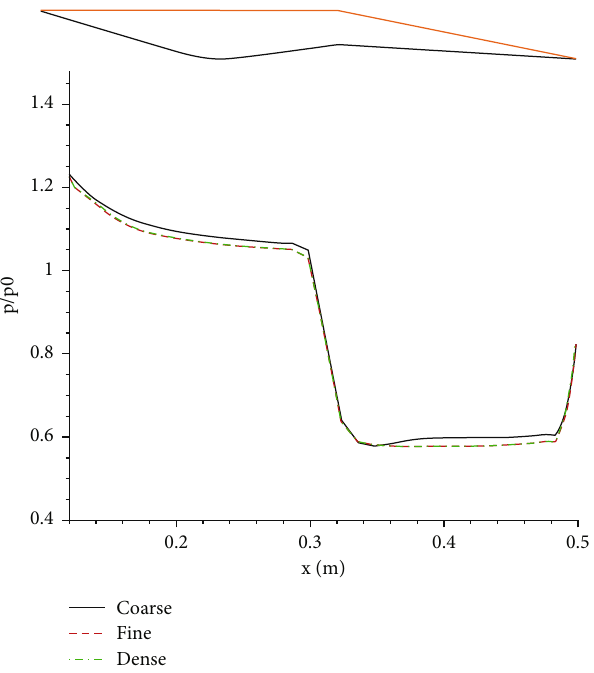
Figure 6: Pressure curves for grid-independence veri fi